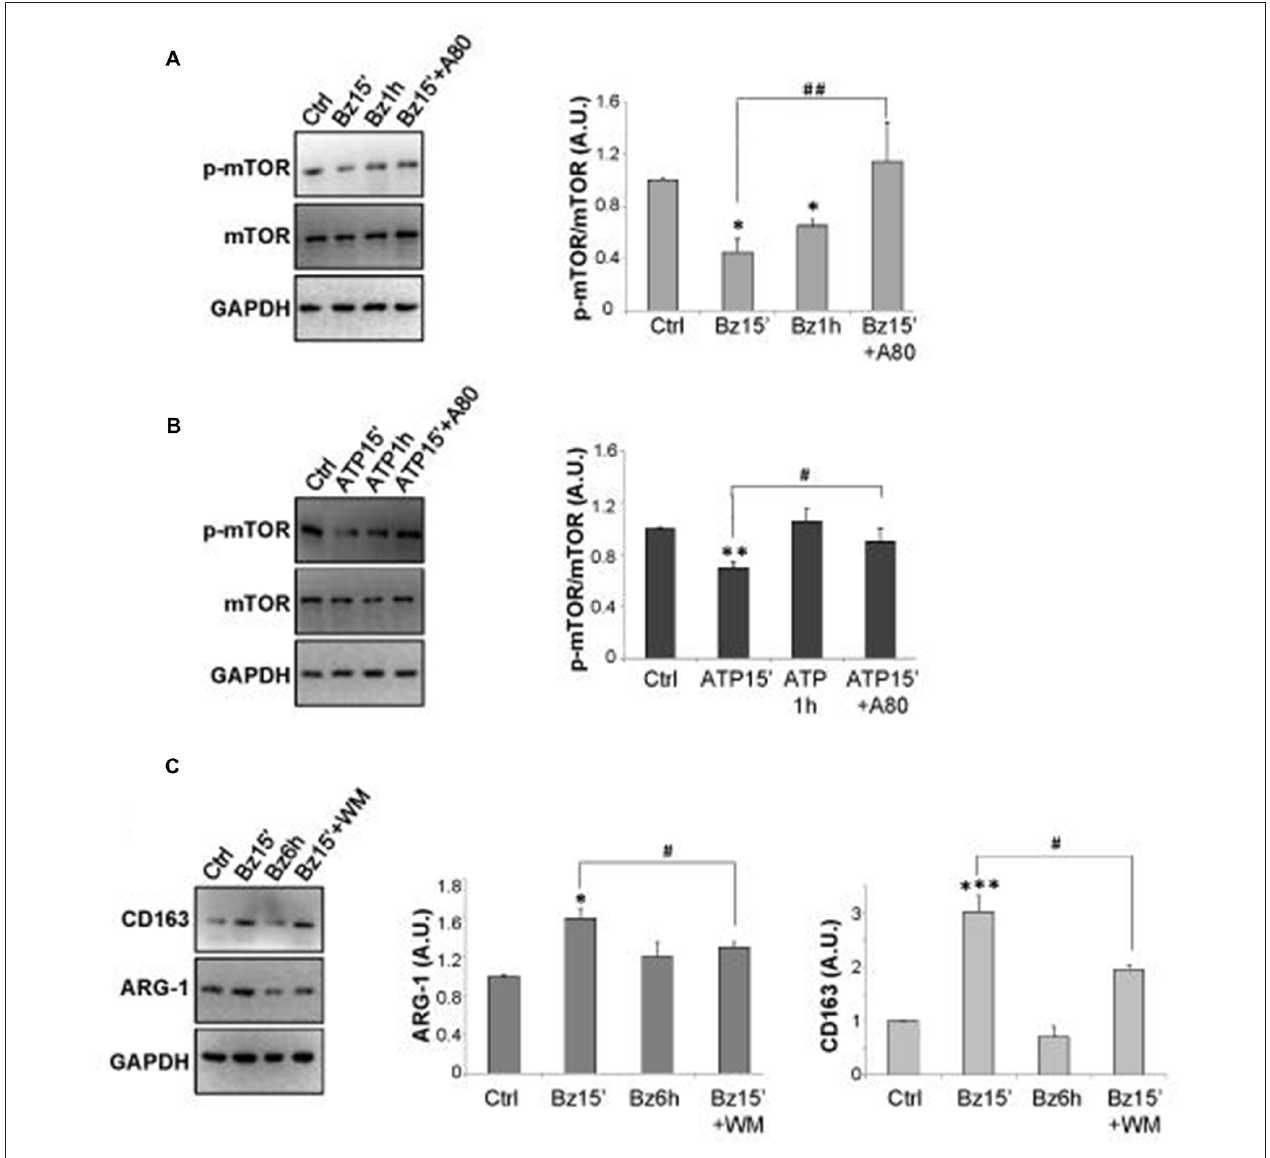
FIGURE 3 | mTOR phosphorylation is regulated by P2X7 activation in SOD1-G93A microglia. SOD1-G93A microglia were treated with 300 µ M BzATP (A) or 3 mM ATP (B) for 15 min or 1 h with or without 10 µ M A-804598 and subjected to western blotting and immunoreactions with anti-p-mTOR and anti-mTOR or anti-GAPDH. SOD1-G93A cells exposed to 300 µ M BzATP for 15 min with or without WM or 6 h were subjected to western blotting and immunoreactions with anti-Arginase-1 (ARG-1) (C) or anti-CD163 and anti-GAPDH. Data represent mean ± SEM of n = 3 independent experiments. Statistical significance was